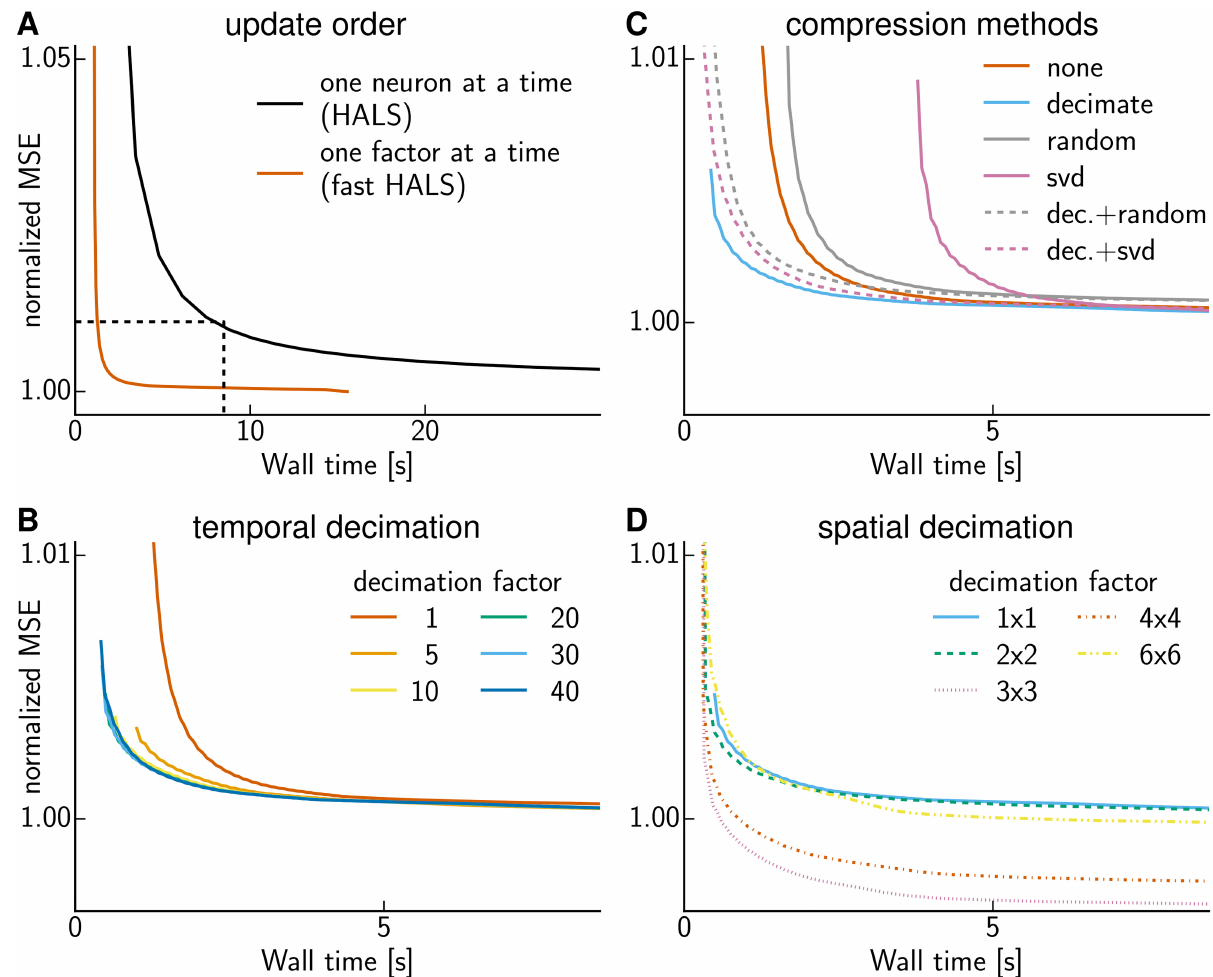
Fig 1. Speeding up CNMF. Mean-squared-error as a function of wall time. (A) The order in which coordinatesin the block-coordinate descent method are updatedaffects convergence speed. The dashedbox indicatesthe zoomed in plot regionof (B, C, D) (B) Temporal decimationspeeds up CNMF. Curves show the normalized mean squareerror (MSE; normalizedso that at convergence the originalCNMF method reachesa value of 1) on the whole data after 30 initial iterations are performed on a smaller dataset obtainedby temporally decimatingby different factors k —i.e., averagingeach block of k frames into a single frame (color indicates k , cf. legend).The curve for decimationfactor 1 (i.e., no decimation) is identicalto the one in (A). (C) Temporal decimationoutperforms other compression schemes. Compressingfurther after decimation(dashedlines) is not beneficial.The cyan and vermilioncurve are the same as in (A,B). (D) Spatial decimation(locally averagingover spatial blocks of size l × l in the image) yields further improvements, in particulara better (local) minimum of the MSE. Curves show the results for 30 initial iterations on data that has been decimatedtemporally by a factor of 30 and spatiallyby the factors l given in the legend.The solid cyan curve for spatialdecimationfactor 1 × 1 (i.e., no spatialdecimation) is the same as in (B, C).